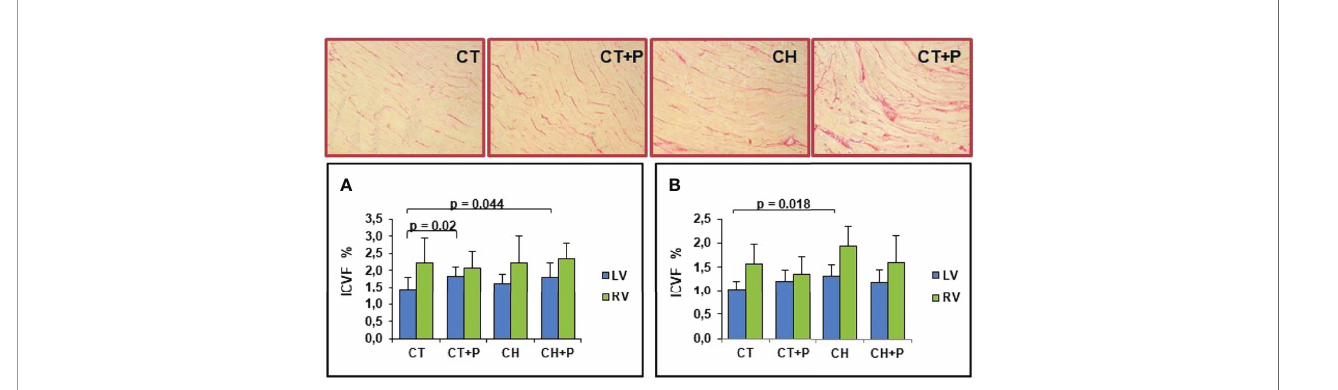
FIGURE 1 | Photomicrograph of the myocardium stained with picrosirius red (in red the collagen marking), and graphic of Interstitial Collagen Volume Fraction (ICVF). (A) Collagen deposition in the acute phase (n=51); (B) collagen deposition in the chronic phase (n=40). CT - control group, CT+P – control group exposed to pollution, CH – chagasic group, CH+P – chagasic group exposed